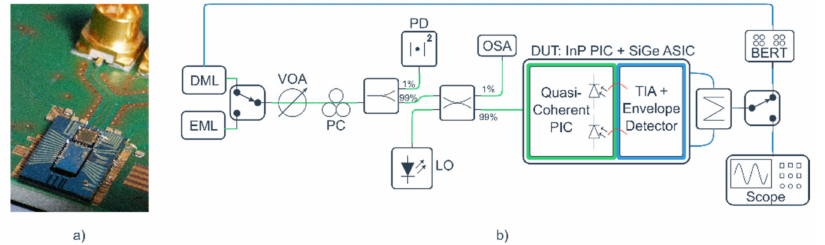
Figure 7. ( a ) Detailed image of the co-hosted InP PIC and SiGe ASIC; ( b ) Block diagram of the device under test (DUT) and setup layout for its